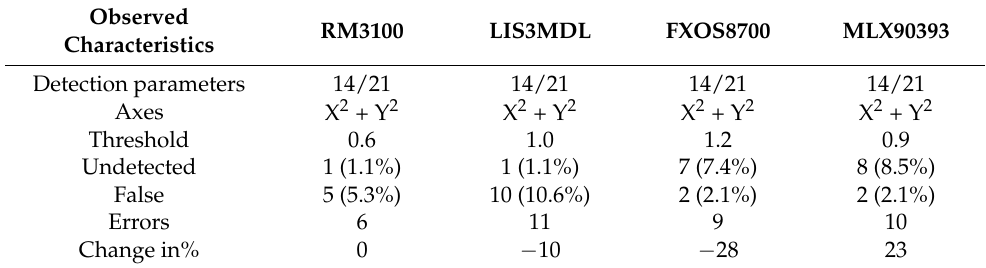
Table 9. Detection parameters and results for measurement